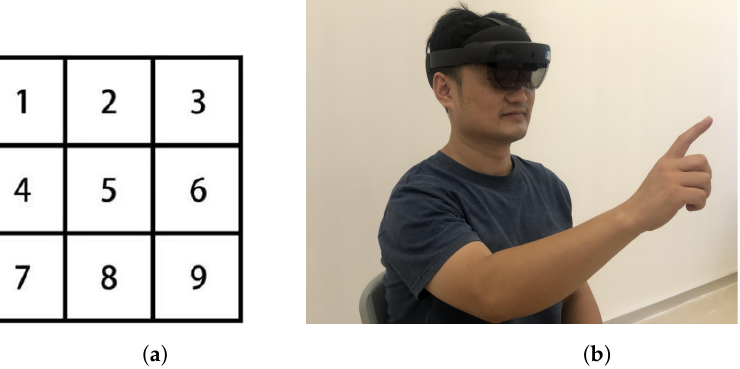
Figure 2. Target layout and experimental settings. ( a ) Target Layout; ( b ) Experimental